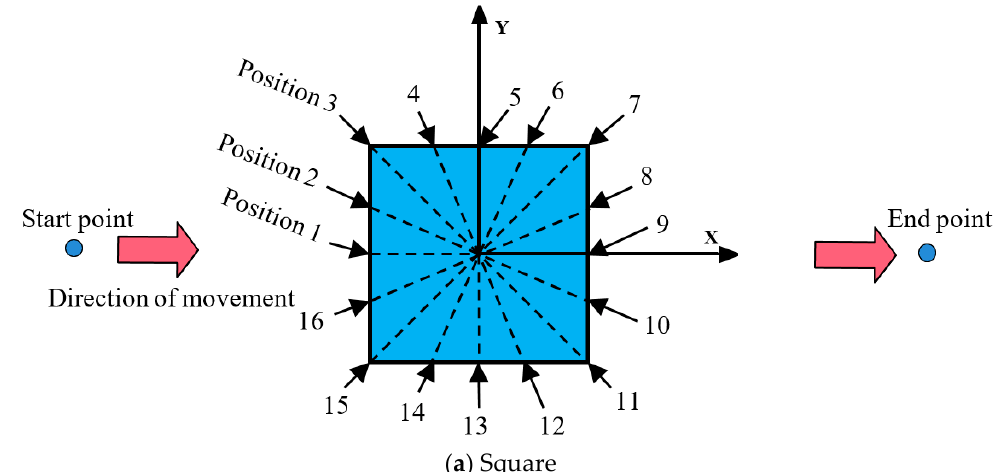
Table 2. Different regular geometric shapes (cylinder and cone), made of aluminum and